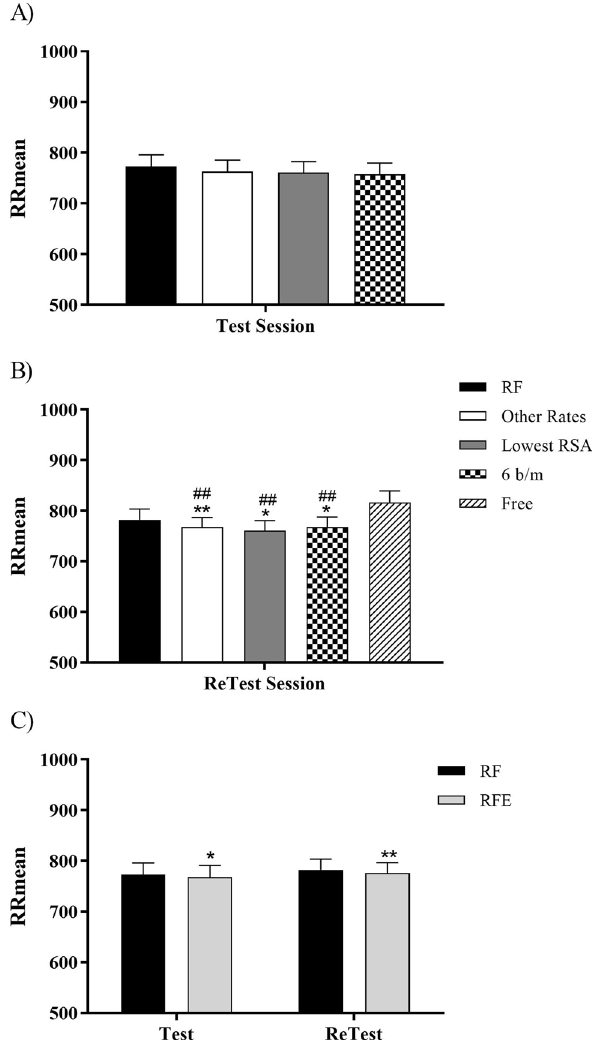
Figure 4. The mean interval time (ms) between heart beats (IBImean or RRmean) is represented for Test ( A ), ReTest ( B ) and RF-RFE comparison ( C ). “RF” represents the optimal resonance frequency, “Other Rates” represents the mean of the other breathing rates, “Lowest RSA” represents the lowest RSA amplitude, “6 b/m” represents the rate of 6 breathes per minute, “Free” represents the free slow breathing session only in retest, and “RFE” represents the expanded RF that consists on taking the IBImean of the nearest below and above rates from the RF. (Non-parametric Wilcoxon test has been performed when Friedman test showed significant differences.). * (p < 0.05) and ** (p < 0.01) mean differences with respect to RF in the same session. ## (p < 0.01) means differences with respect to Free Respiration in the same